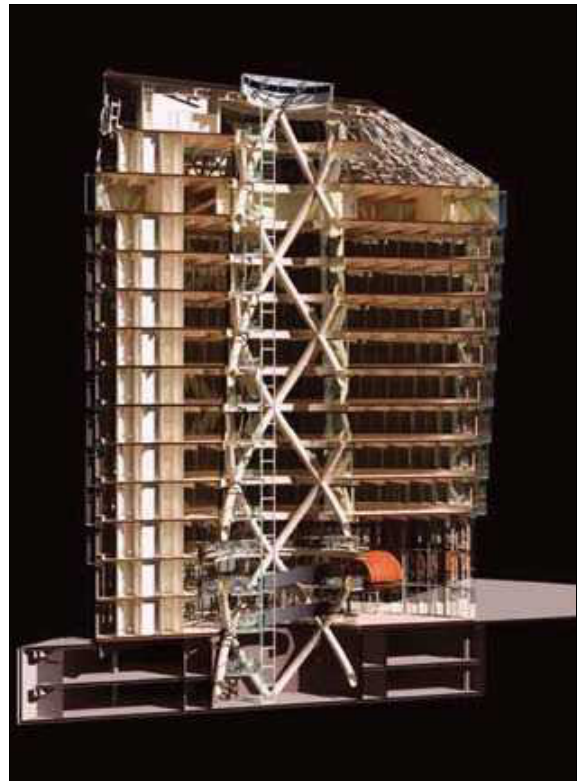
Fig. 7. “s­ba­” concer­n centr­al office in Vilniu­s. PLh a­r­kitekter­. Vir­tu­al model